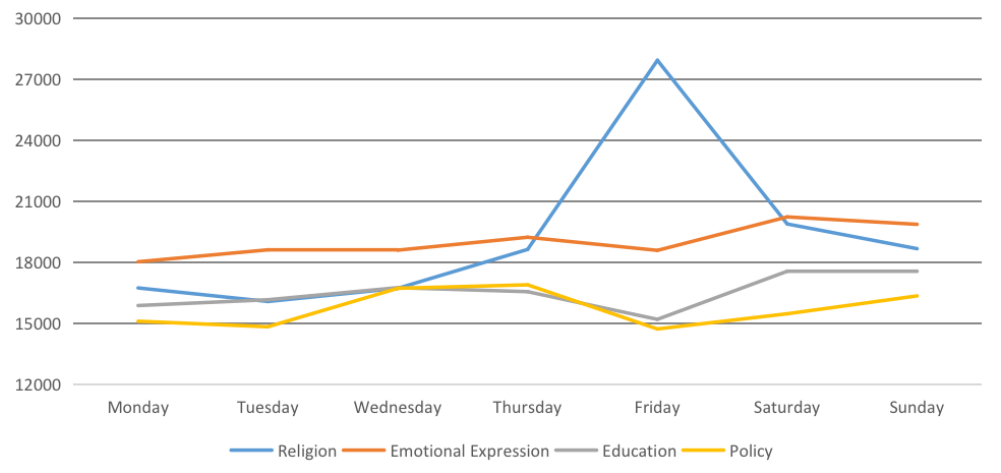
Figure 8. The number of tweets related to topics across week